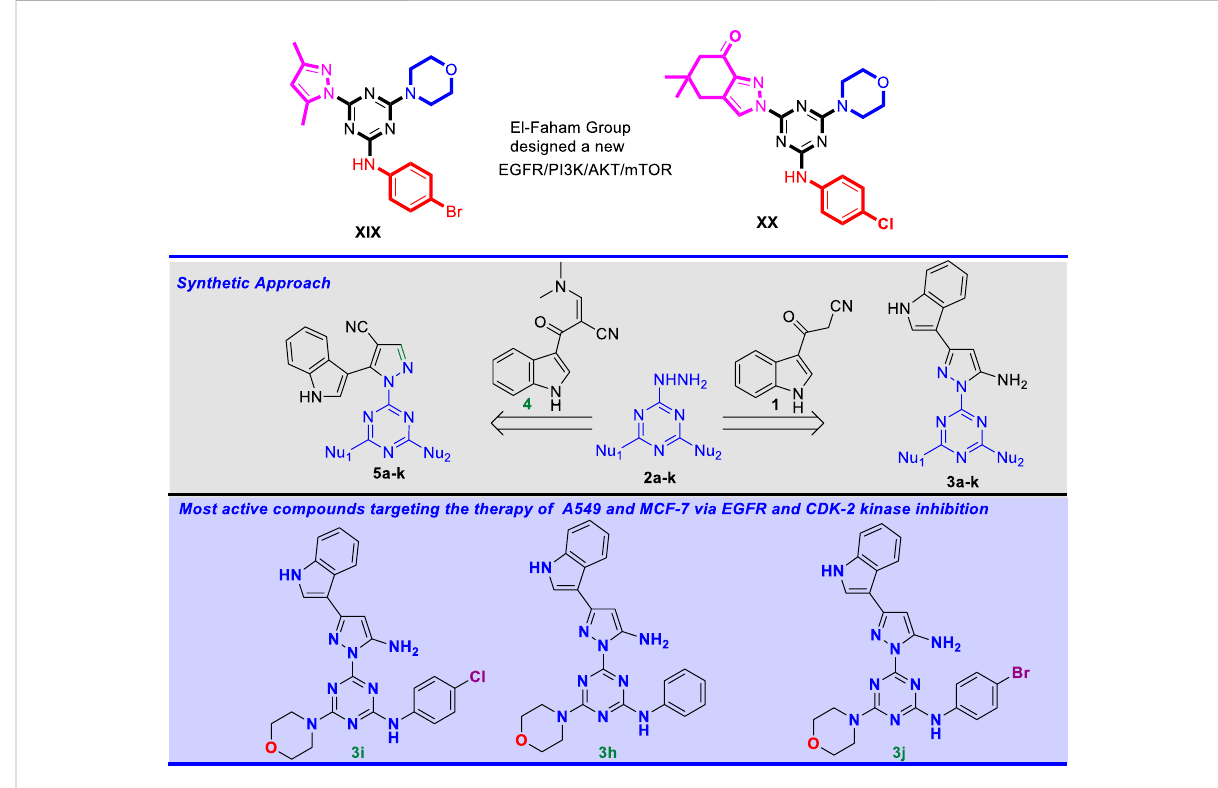
FIGURE 2 Novel pyrazolyl-s-triazine derivatives synthesized by our group targeting the EGFR/PI3K/AKT/mTOR cascade and CDK-2